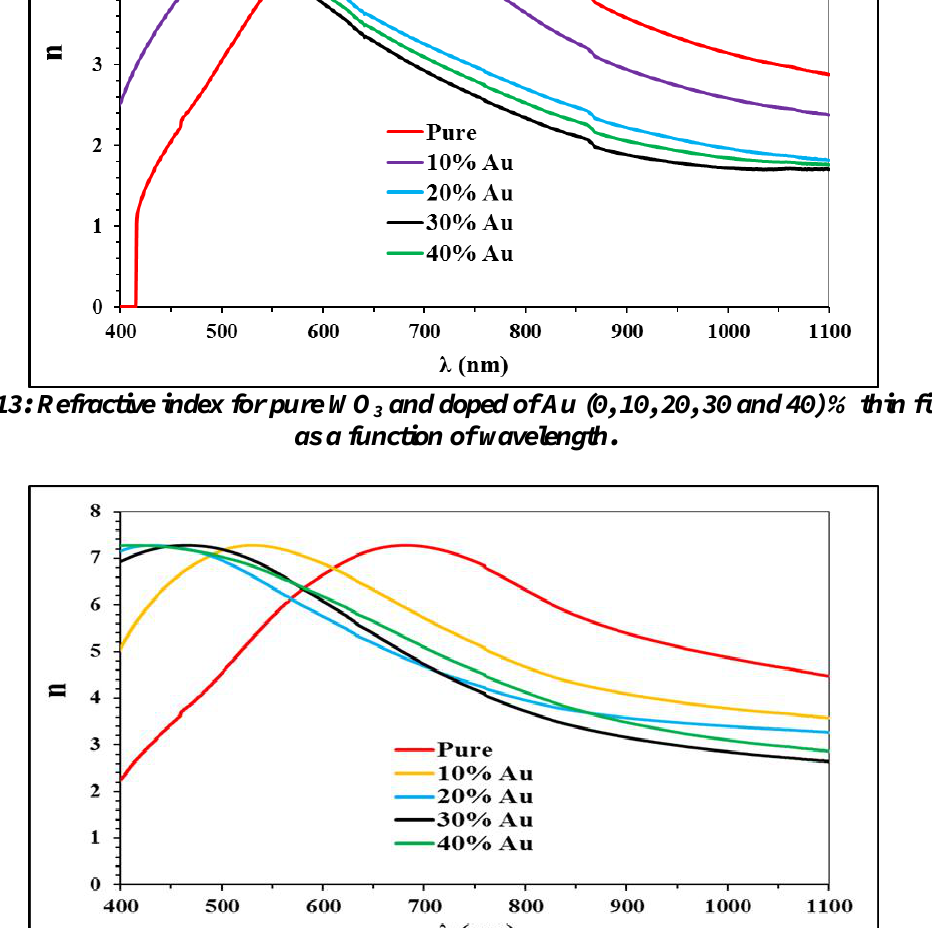
and doped of Au (0, 10, 20, 30 and 40) % thin films 3 as a function of wavelength at T =400 a